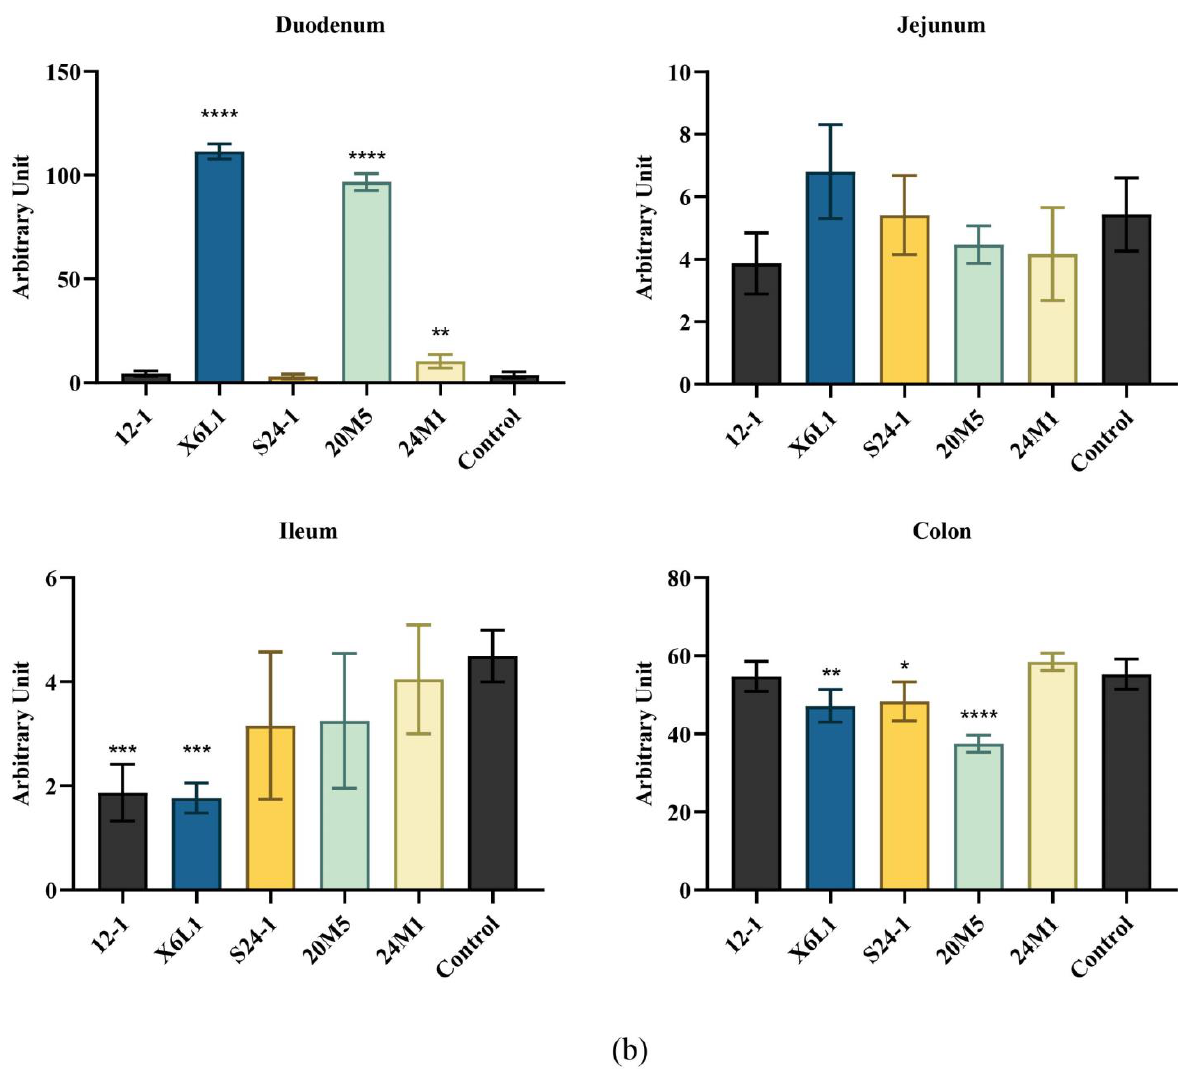
Figure 3. Effect of L. fermentum on IgA + plasma cell in intestinal tract of normal mice.( a ) The IgA immunofluorescence map of each intestinal segment of mice was obtained from the visual field of the photos intercepted by the CaseViewer (10×, green-IgA, blue-DAPI); ( b ) The average fluorescence intensity of immunofluorescence images of mouse intestinal tissues treated by Image J ”*” indicates p < 0.05, and “**” indicates p < 0.01, “***” indicates p < 0.001, “****” indicates p < 0.0001 (compared with the control group).